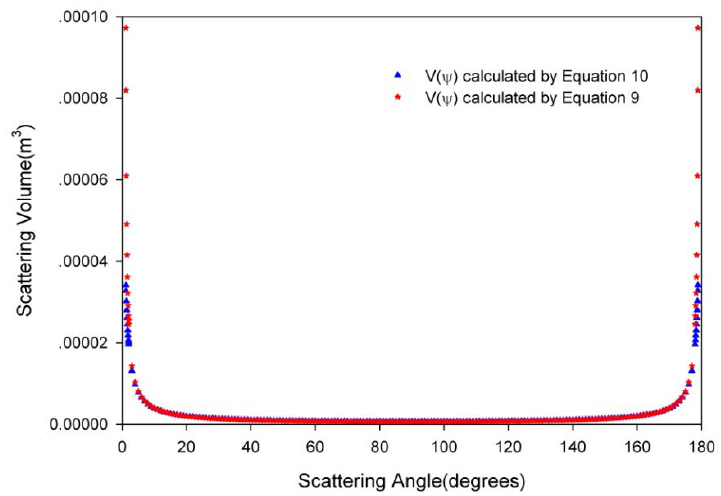
Figure 7. The V ( ψ ) calculated from Equations (9) and